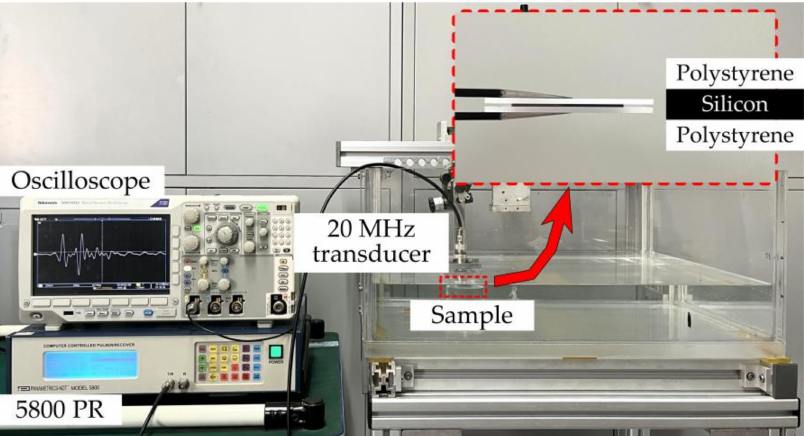
Figure 11. The 20 MHz experimental